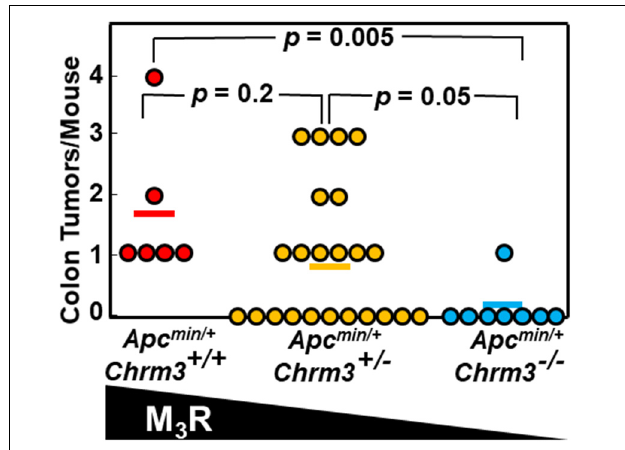
FIGURE 5 | M 3 R deficiency attenuates colon tumor formation in Apc min / + mice with aberrant β -catenin signaling. In Apc min / + mice with aberrant β -catenin signaling resulting in exuberant intestinal polyposis, M 3 R deficiency attenuates colon tumor formation. Apc min / + mice with varying M 3 R expression were created as described in Methods. We euthanized mice at 14 weeks of age, harvested colons, and counted and analyzed tumors. Each symbol represents one Apc min / + mouse; bars show